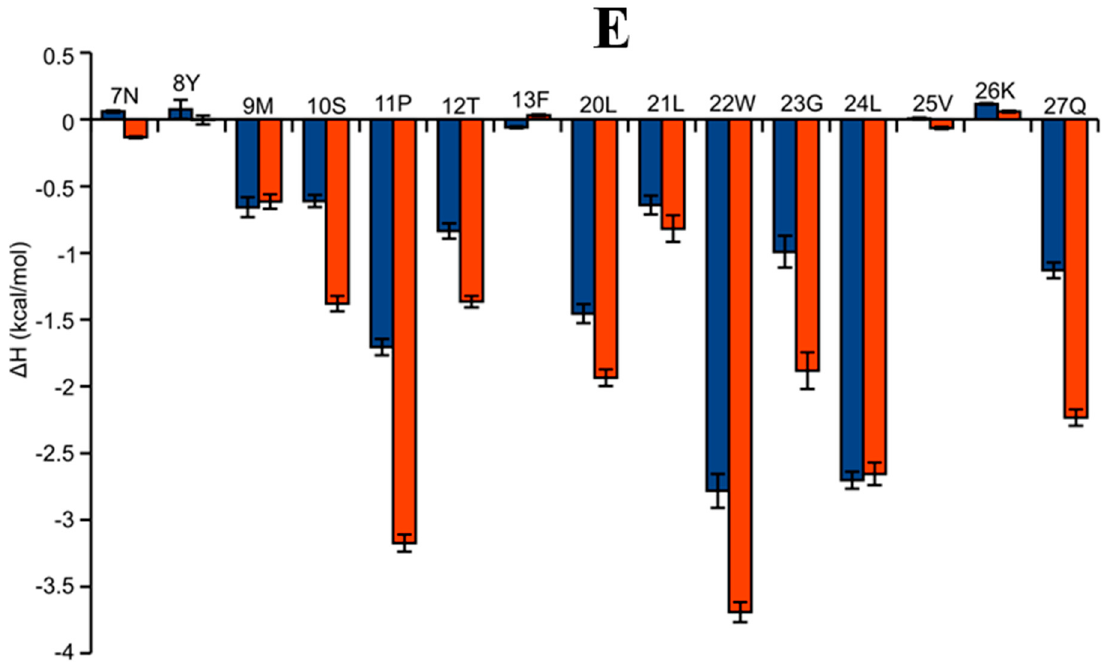
Figure 6. Binding modes of AAI (orange, A ) and ingenol mebutate (green, C ) to PKC δ Cys2 domain. The binding site of the receptor is shown using transparent surface area, and the H-bond is represented using dashed line; the blue spot is used to show the solvent exposure of the atoms for AAI ( B ) and ingenol mebutate ( D ), light green circles: hydrophobic amino acids; magenta circles: hydrophilic amino acids; blue circles: ligand exposure; and the darker color at AAI suggests that these atoms are more solvent exposed; and ( E ) Energetic contribution of residues at the binding site of PKC δ Cys2 domain to the enthalpy change of AAI (blue) and ingenol mebutate (red).